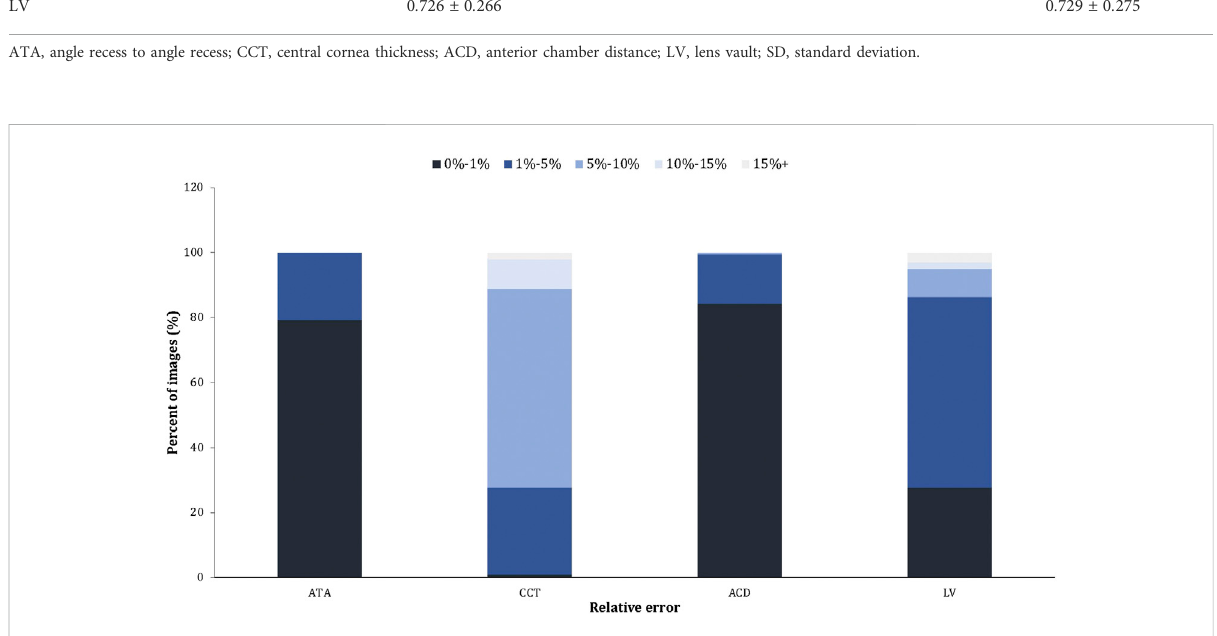
FIGURE 3 The relative error of the automated measurement (Machine vs. Ground truth). The relative error = the absolute error/the ground truth ×